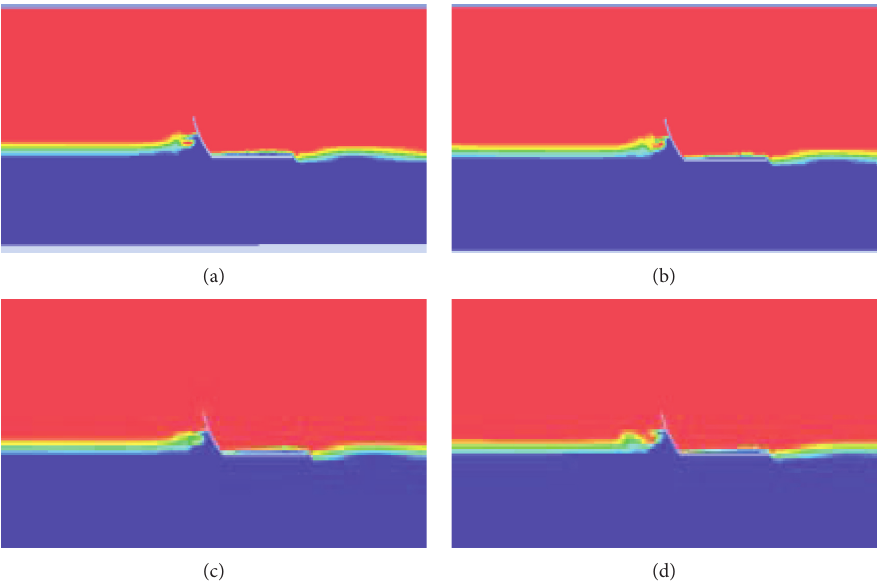
Figure 9: Simulation results of different penetrating angle: (a) penetrating angle is 5 ° , (b) penetrating angle is 10 ° , (c) penetrating angle is 15 ° , and (d) penetrating angle is 20 °